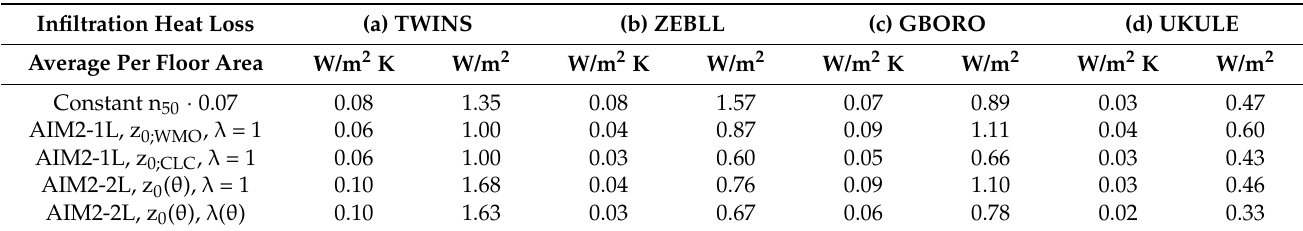
Table 5. Infiltration loss calculated mean over the six month winter period per floor area in W/Km 2 and assuming an indoor temperature of 21 ◦ C in W/m 2 heated floor